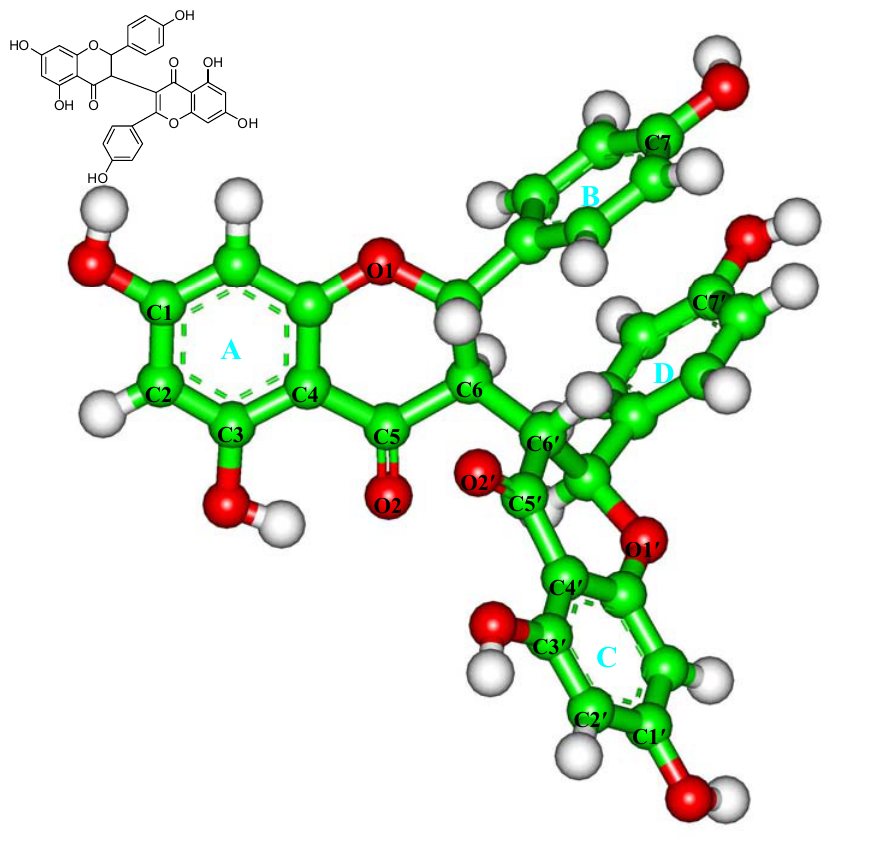
Figure 1. Structure of chamaejasmine.